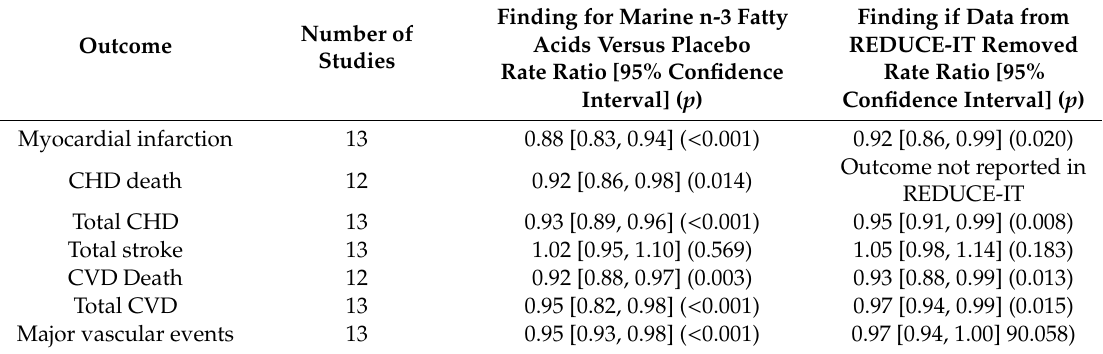
Table 4. Summary of findings from the meta-analysis published by Hu et al. [81] in